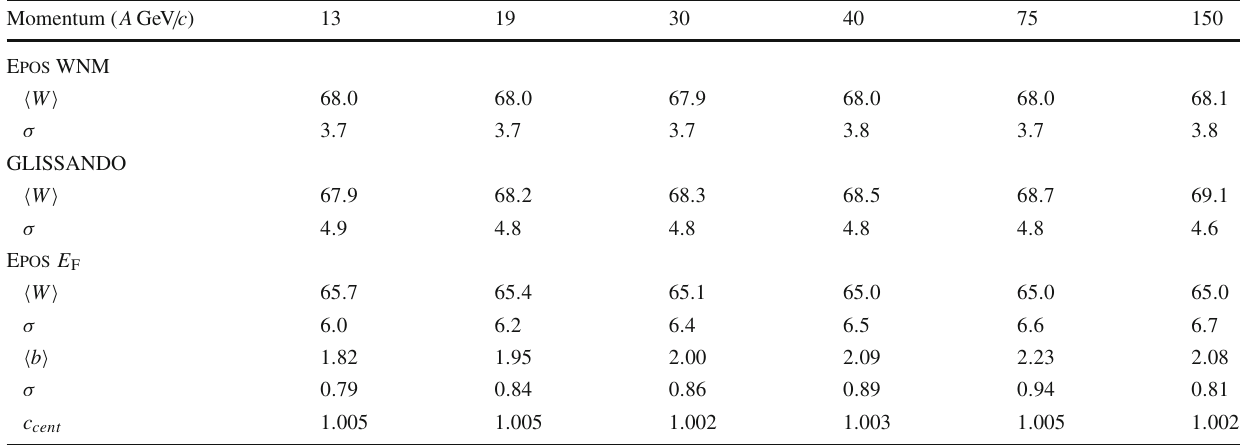
Table 2 Average number of wounded nucleons (cid:5) W (cid:6) in the 5% most central Ar+Sc collisions estimated from simulations using the Epos [17–19] and GLISSANDO [24] models. In the Epos WNM case the average impact parameter (cid:5) b (cid:6) is presented as well. The values of σ denote the widths of the distributions of W and b . Results from